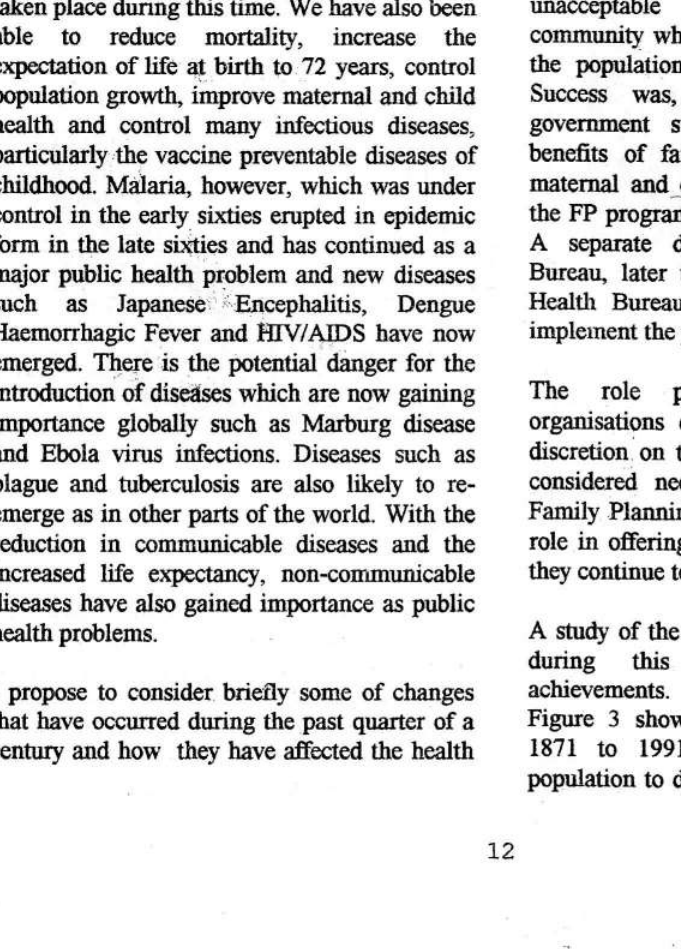
Table l: Health Tndicators 1970 and 1995 1970 1995 Crude birth rate (per 1000 pofr ) 29.4 20.0 Crudedeathrate(per1000popn)